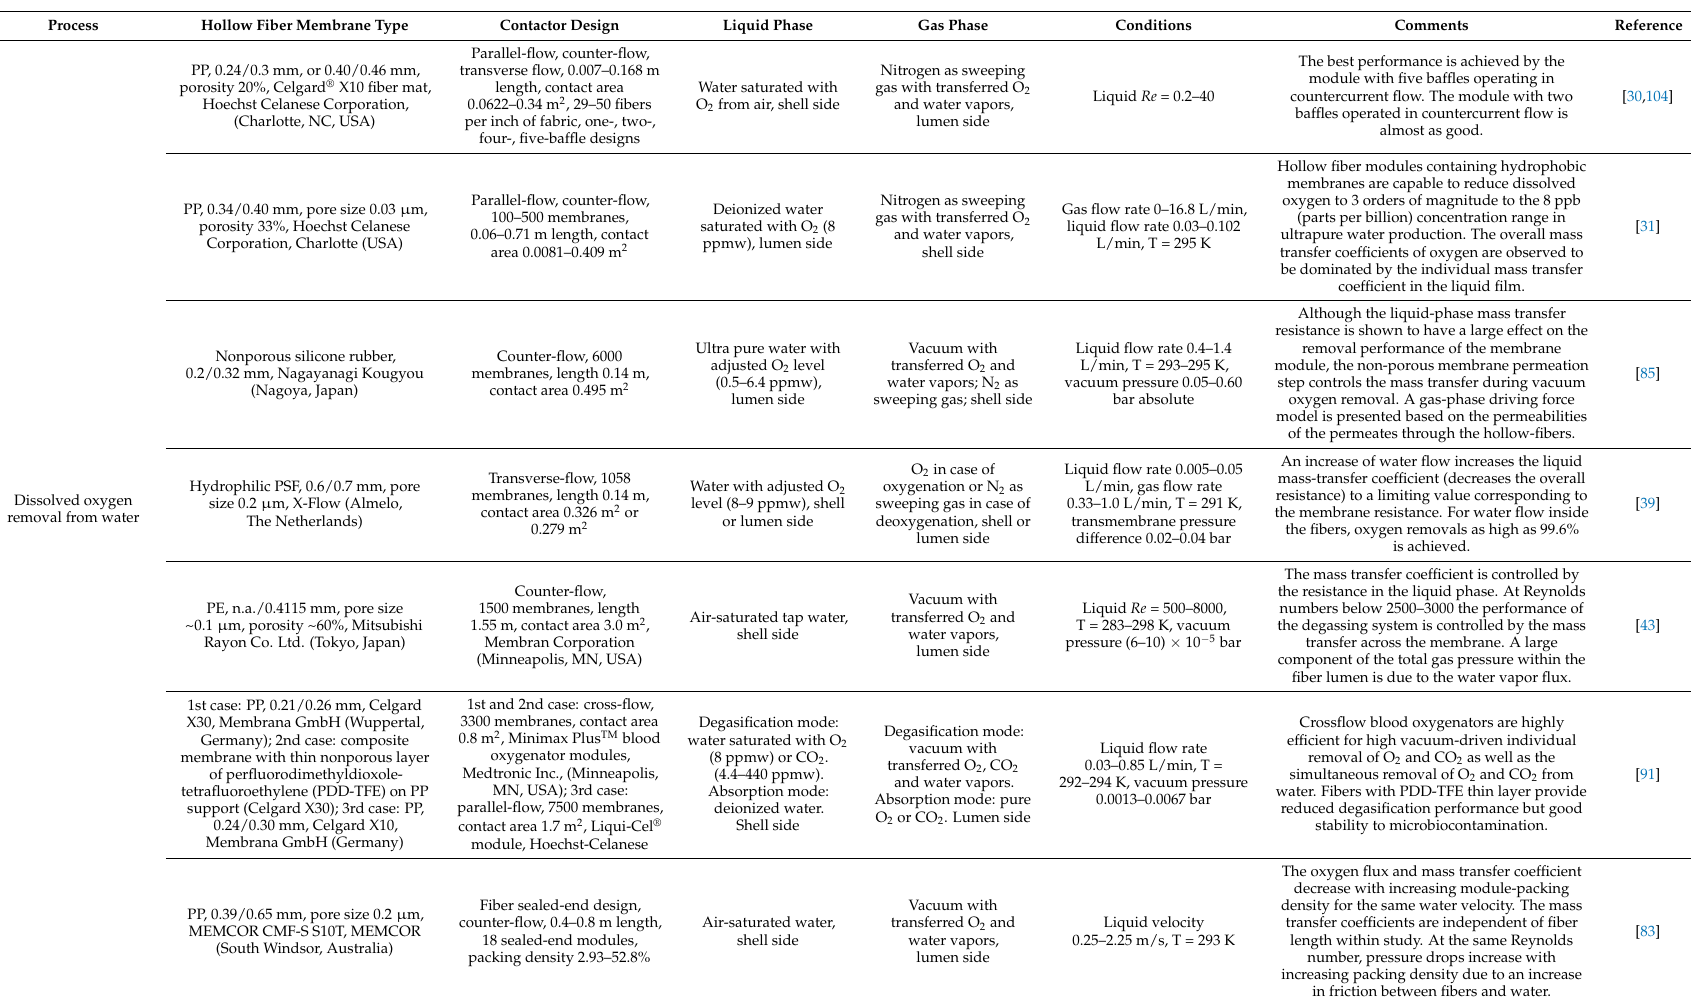
Table 4. Studies on membrane